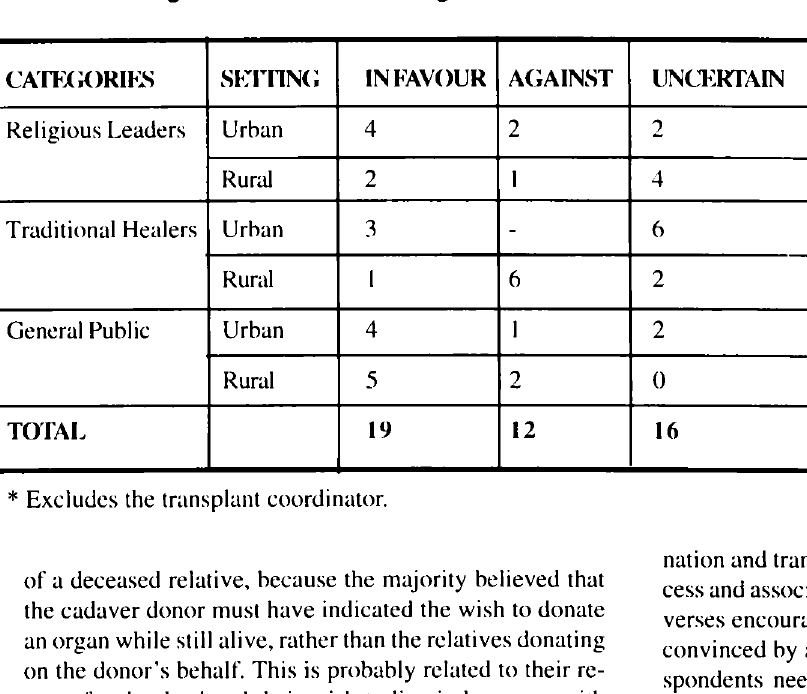
Table 2: Willingness to donate an organ at death